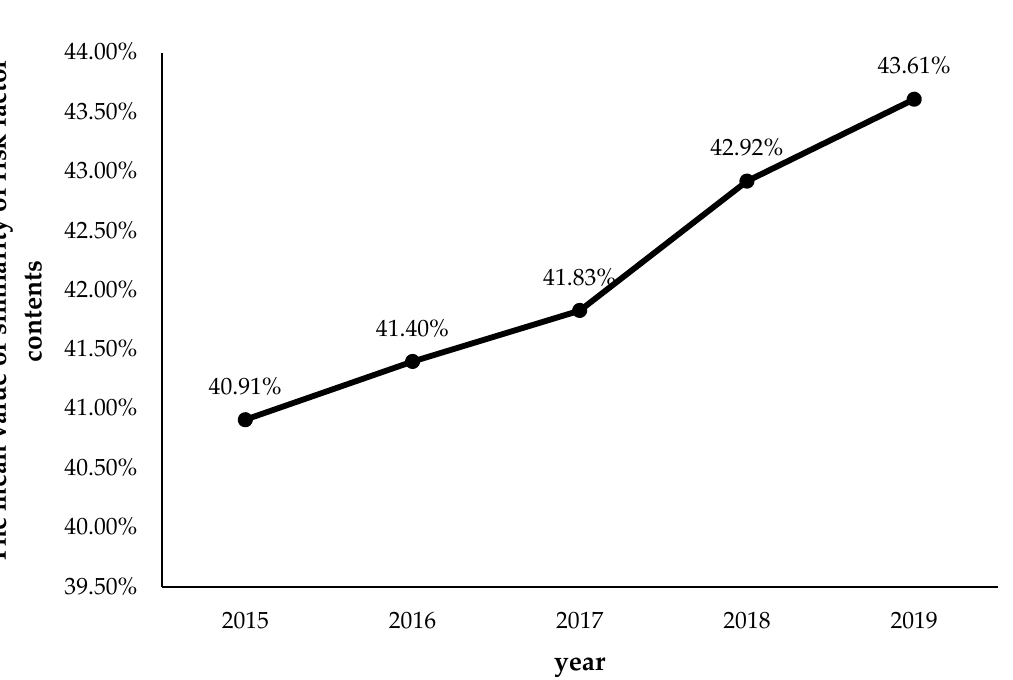
Figure 5. The change of the mean value of the similarity of risk factor contents from 2015 to 2019.